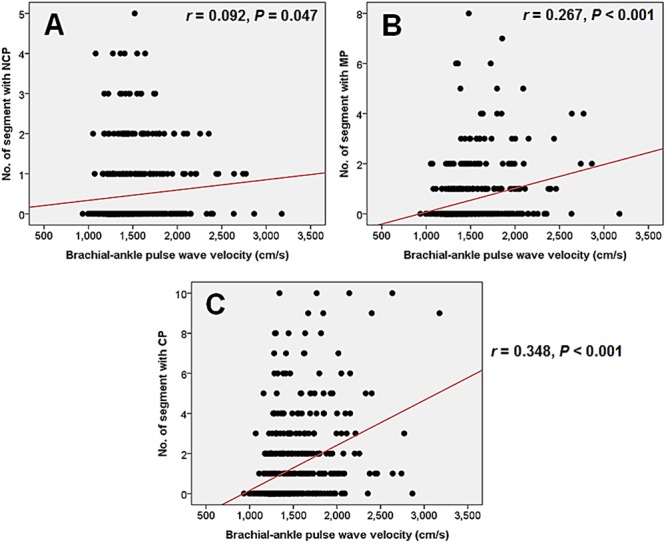
The associations between brachial-ankle pulse wave velocity and plaque characteristics of coronary artery disease.Graphs show the associations of baPWV and the number of coronary segment with noncalcified plaque (A), mixed plaque (B), and calcified plaque (C). NCP, non-calcified plaque; MP, mixed plaque; CP, calcified plaque.